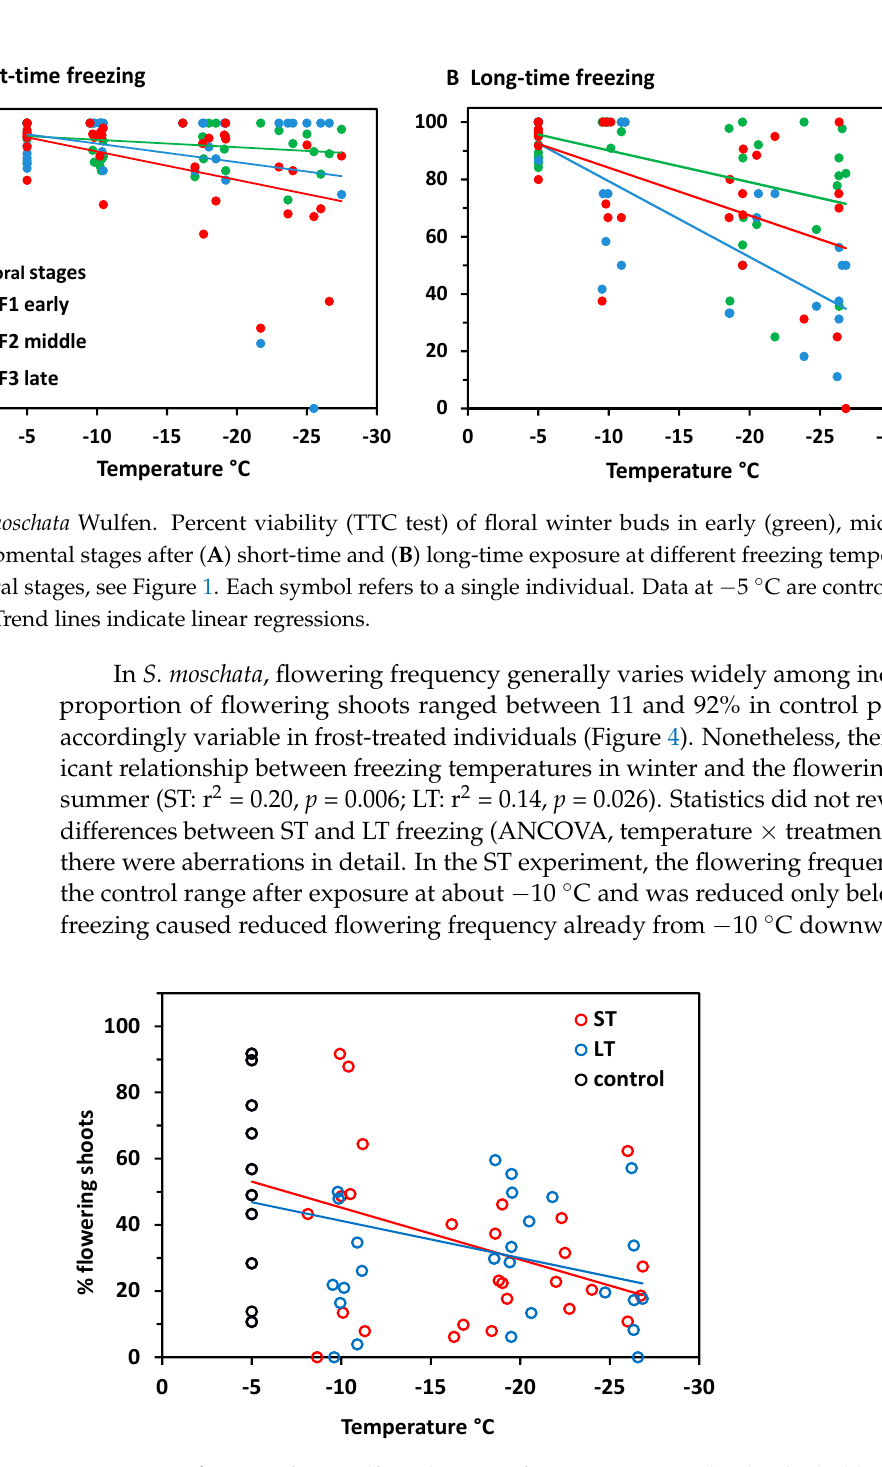
Figure 4. Saxifraga moschata Wulfen . Flowering frequency in control individuals (black circles), and in individuals after short-time (ST, red circles) and long-time (LT, blue circles) exposure in winter. Each symbol indicates the proportion of flowering shoots based on the total number of shoots (generative and vegetative) per individual. Trend lines indicate linear regressions.